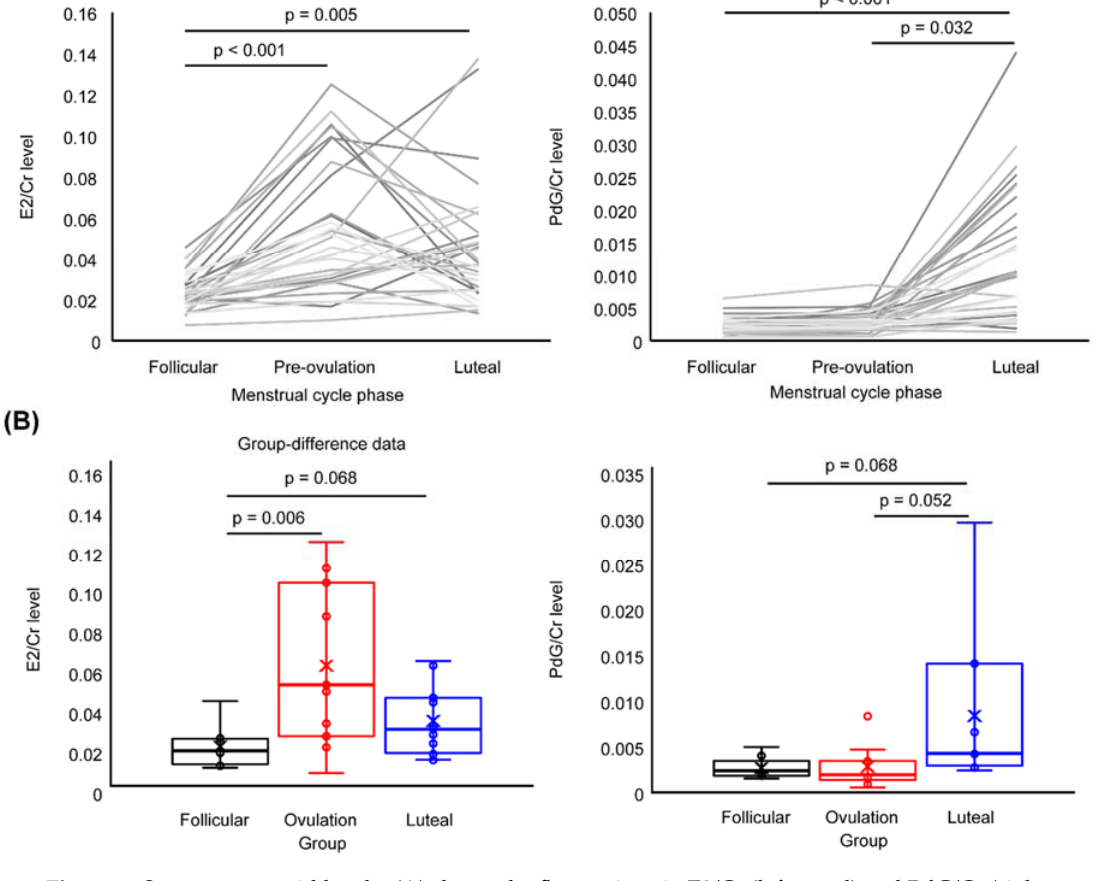
Figure 3. Sex neuro-steroid levels. ( A ) shows the fluctuations in E2 / Cr (left panel) and PdG / Cr (right Figure 3. Sex neuro ‐ steroid levels. ( A ) shows the fluctuations in E2/Cr (left panel) and PdG/Cr (right panel) levels across menstrual cycle phases in each participant ( n = 31). E2 / Cr levels increased in the panel) levels across menstrual cycle phases in each participant ( n = 31). E2/Cr levels increased in the preovulation and luteal phases relative to the follicular phase. The PdG / Cr level increased in the luteal preovulation and luteal phases relative to the follicular phase. The PdG/Cr level increased in the luteal phase compared to the other phases. ( B ) presents the group di ff erences in E2 / Cr (left panel) and PdG / Cr phase compared to the other phases. ( B ) presents the group differences in E2/Cr (left panel) and (right panel) on Day 1. E2 / Cr was highest in the ovulation group, whereas PdG / Cr level was highest in PdG/Cr (right panel) on Day 1. E2/Cr was highest in the ovulation group, whereas PdG/Cr level was the luteal highest in the luteal group.